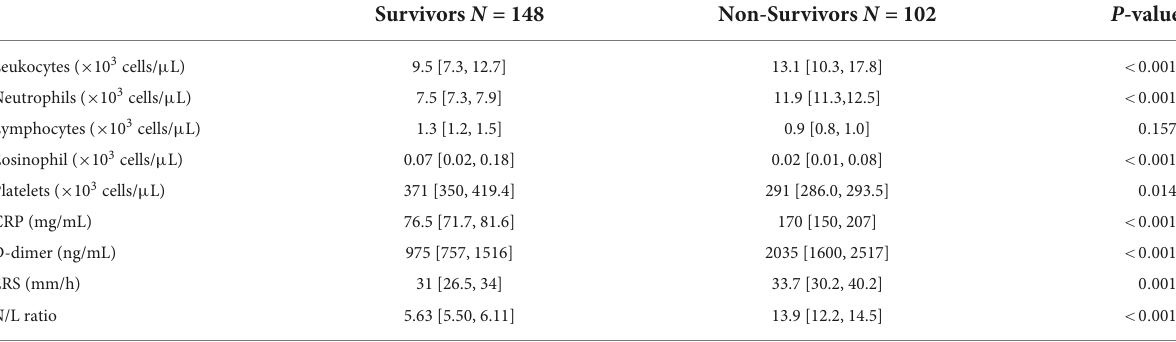
TABLE 1 Comparative analysis of routine biochemical parameters of population according to survival status ( n =